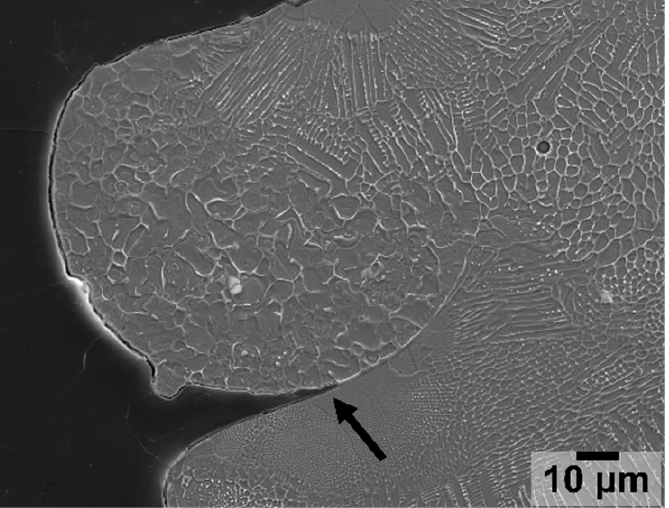
Figure 9. Secondary electron image of a partially un-melted powder particle at the top of the deposited clad.